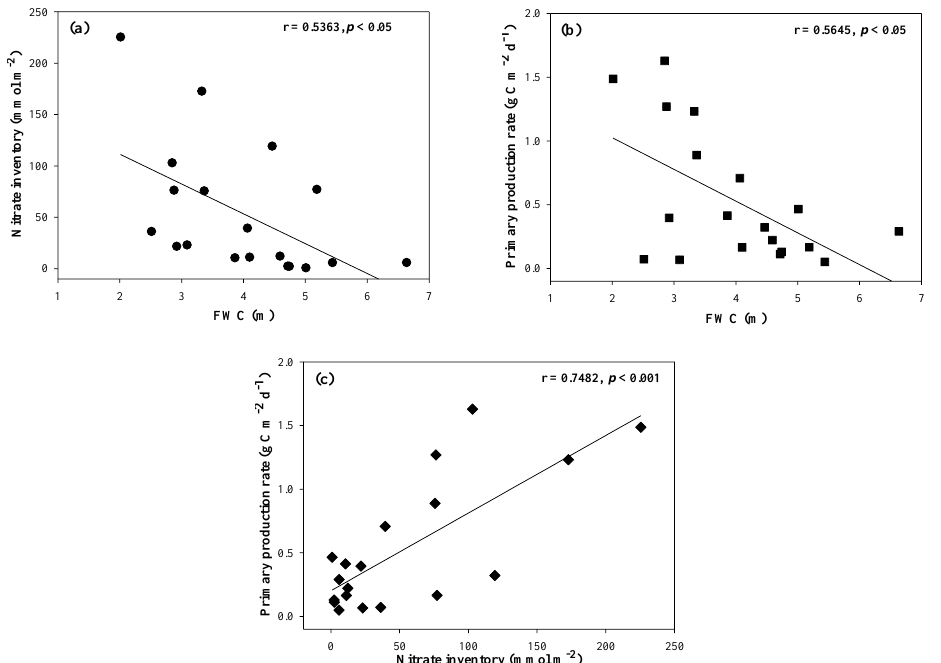
Figure 9. Relationships between (a) FWC (m) and nitrate inventory (mmolm − 2 ), (b) FWC (m) and daily primary production rate (g Cm − 2 d − 1 ), and (c) nitrate inventory (mmolm − 2 ) and daily primary production rate (gCm − 2 d − 1 ). All data obtained from the southern region during the three RUSALCA cruises.